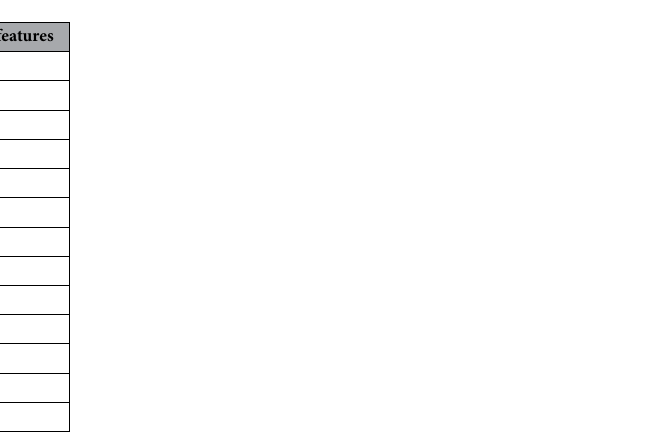
Table 6. Borda count